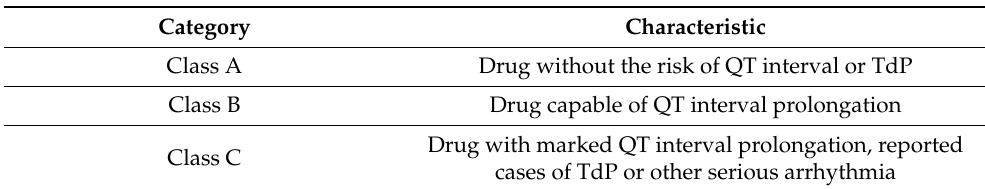
Table 5. Classification of psychotropic drugs according to the risk of QT prolongation interval and the development of arrhythmias [87,88].